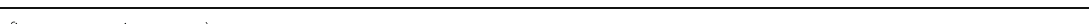
(See figure on previous page.) Fig. 3 Flow cytometry analysis of the distribution of lymphocytes in the lamina propria of GF + PBS mice, GF + B6 mice and GF + SLE mice. ( a ) Histograms of CD19 + B cells. The number is the percentage of CD19 + B cells of live cells. The red histograms show CD19 + cells of live cells. The right statistical results show percentages of B cells in groups (5 mice per group). ( b ) Plots represent CD4 + CD8a − T cells (left) and the percentages of CD4 + CD8a − T cells in 3 groups (5 mice per group; right). ( c ) Plots represent CD4 + ROR γ t + T cells (left) and percentages of CD4 + ROR γ t + cells in 3 groups (5 mice per group; right). ( d ) Plots represent regulatory T cells (Tregs; left) and percentages of Treg cells in 3 groups (5 mice per group; right). Data represent one of three independent experiments. A Mann-Whitney t -test was used to compare groups, and error bars